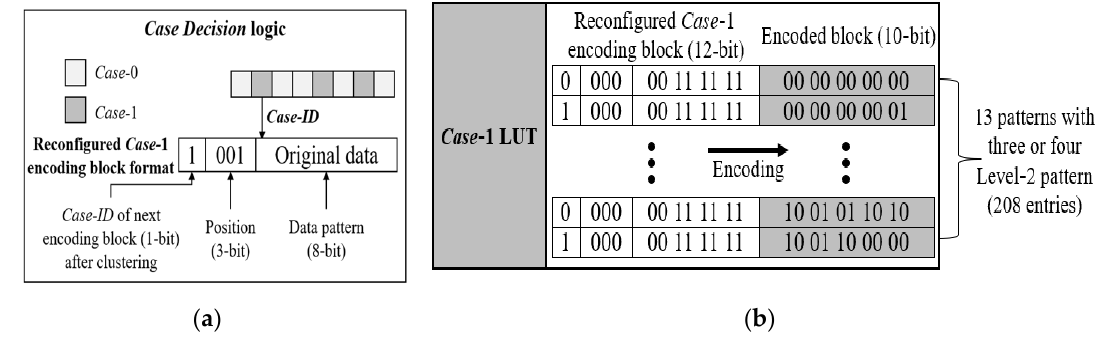
Figure 5. ( a ) Reconfigured Case- 1 encoding block; ( b ) Case- 1 encoder configuration.